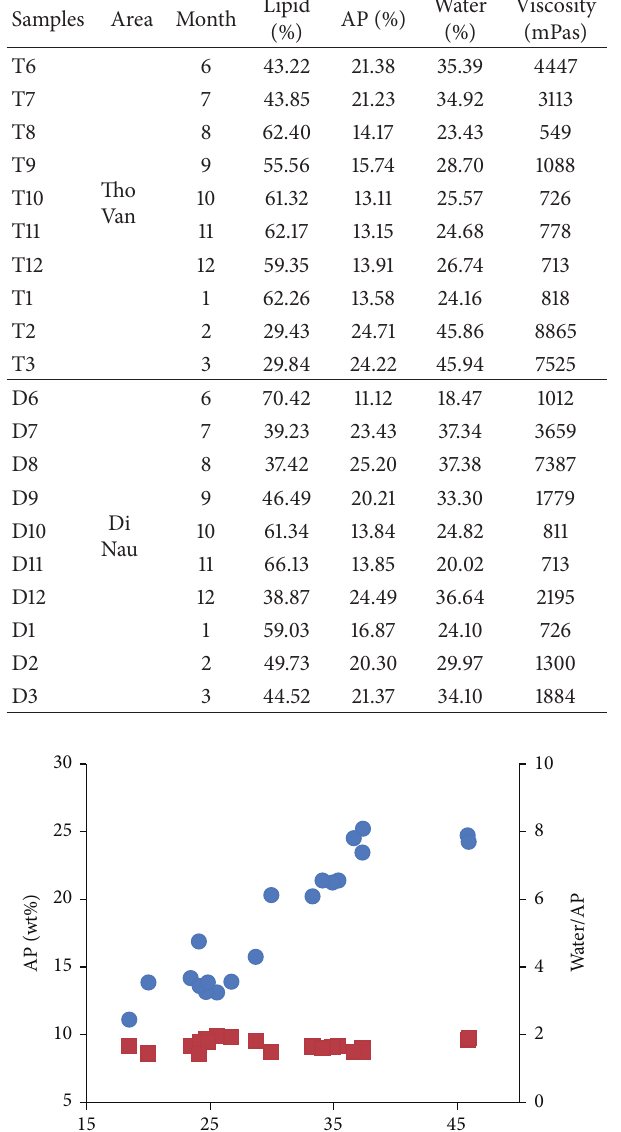
Table 1: Compositions of season Vietnamese lacquer.